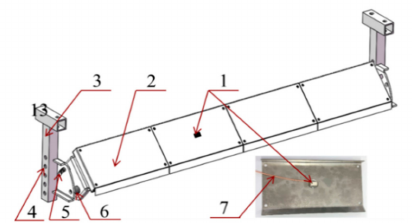
Figure 1. Diagram of assembled cleaning loss sensor structure. ( 1 ) Sensitive element, ( 2 ) Sensitive plate, ( 3 ) Support frame (T-section steel), ( 4 ) Installation longitudinal direction adjuster hole, ( 5 ) Installation angle adjuster plate, ( 6 ) Vibration isolation rubber, ( 7 ) Monitoring unit.